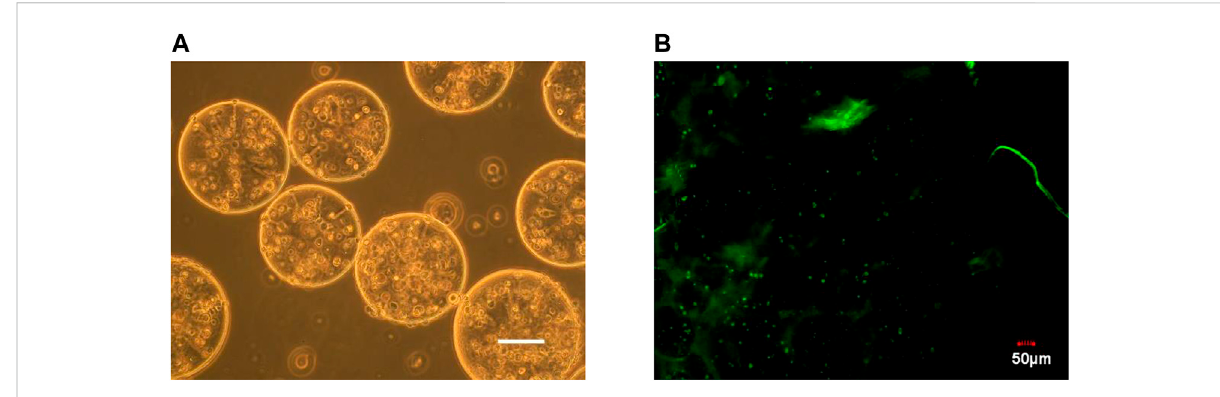
FIGURE 1 Microscopy photograph (A) and confocal laser scanning microscope image (B) of microencapsulated BRL-3A cells. (×200, left bar: 100 μ m).